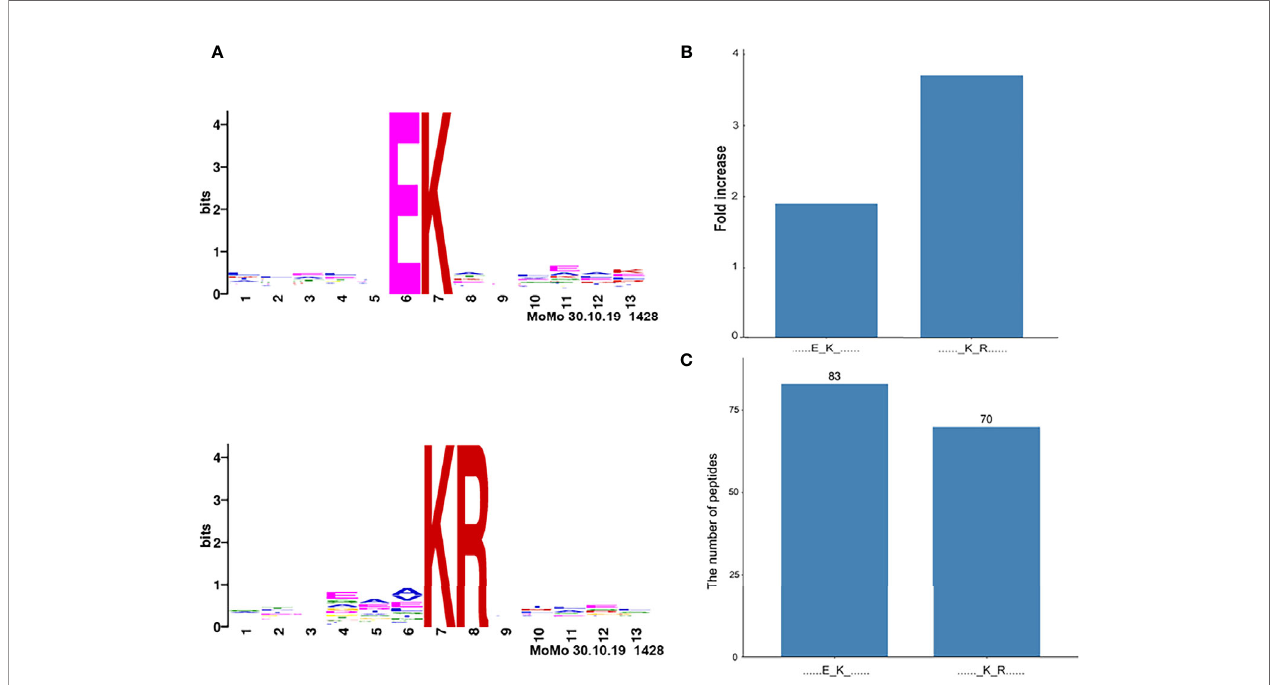
FIGURE 4 | Acetylation motifs of proteins in pituitaries ( Homo sapiens ). (A) Two acetylation motifs of proteins predicted with acetylated peptides. The central K stands for the acetylated lysine residue sites in proteins. The size of each letter is related to the frequency of amino acid residues occurring at that position. (B) The increased fold-change of each acetylation motif. (C) The number of acetylated peptides in each motif. K* = acetylated lysine